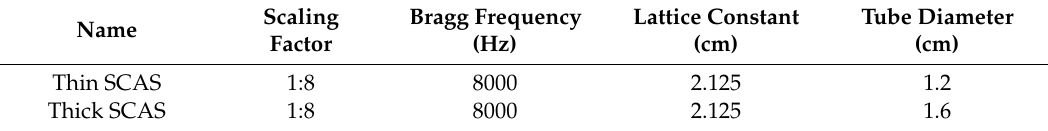
Table 1. Design parameters of thin and thick barriers based on sonic crystals at a scaling factor of 1:8.